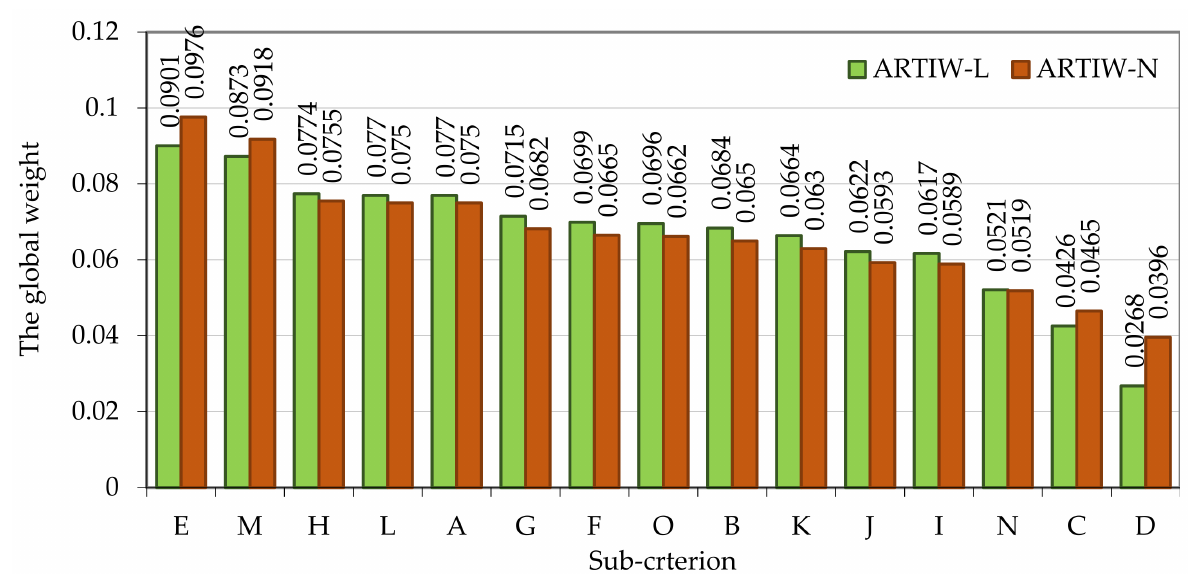
Figure 4. Relative weights of sub-criteria in descending